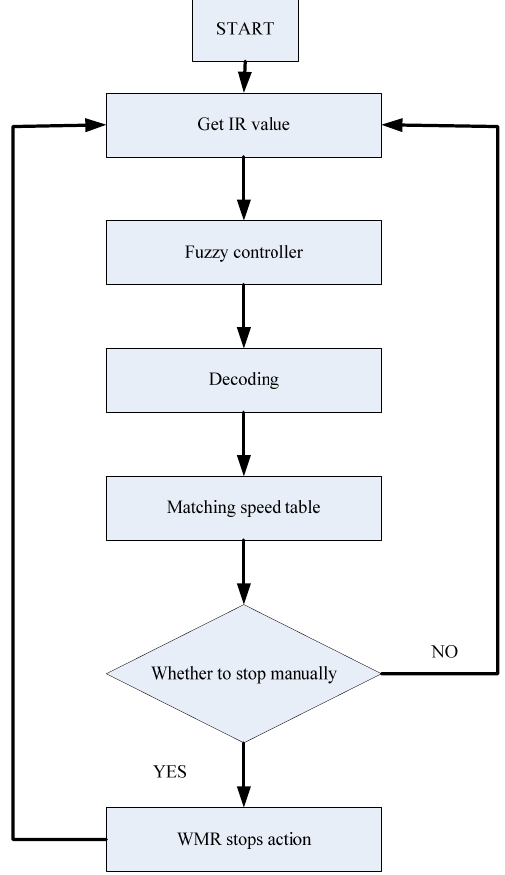
Figure 11. Flowchart of indoor patrol [17].